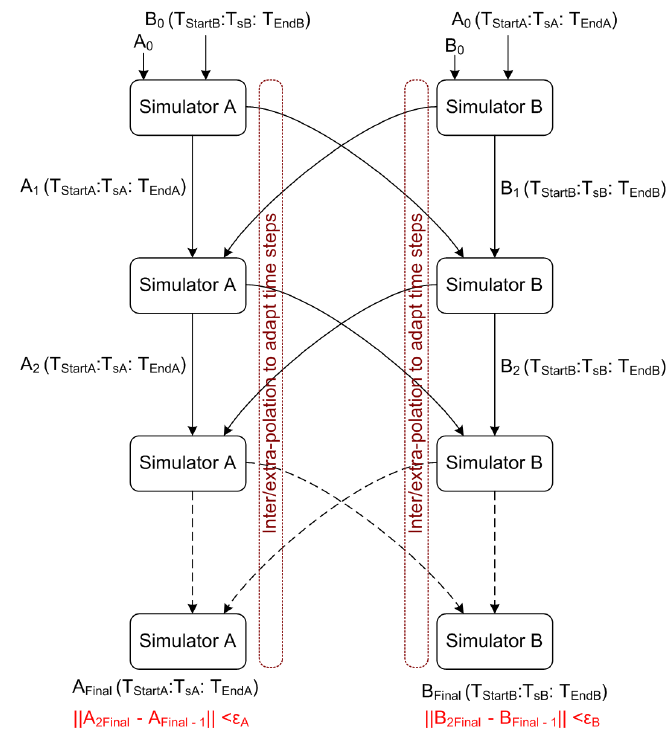
Figure 9. WRM method applied to